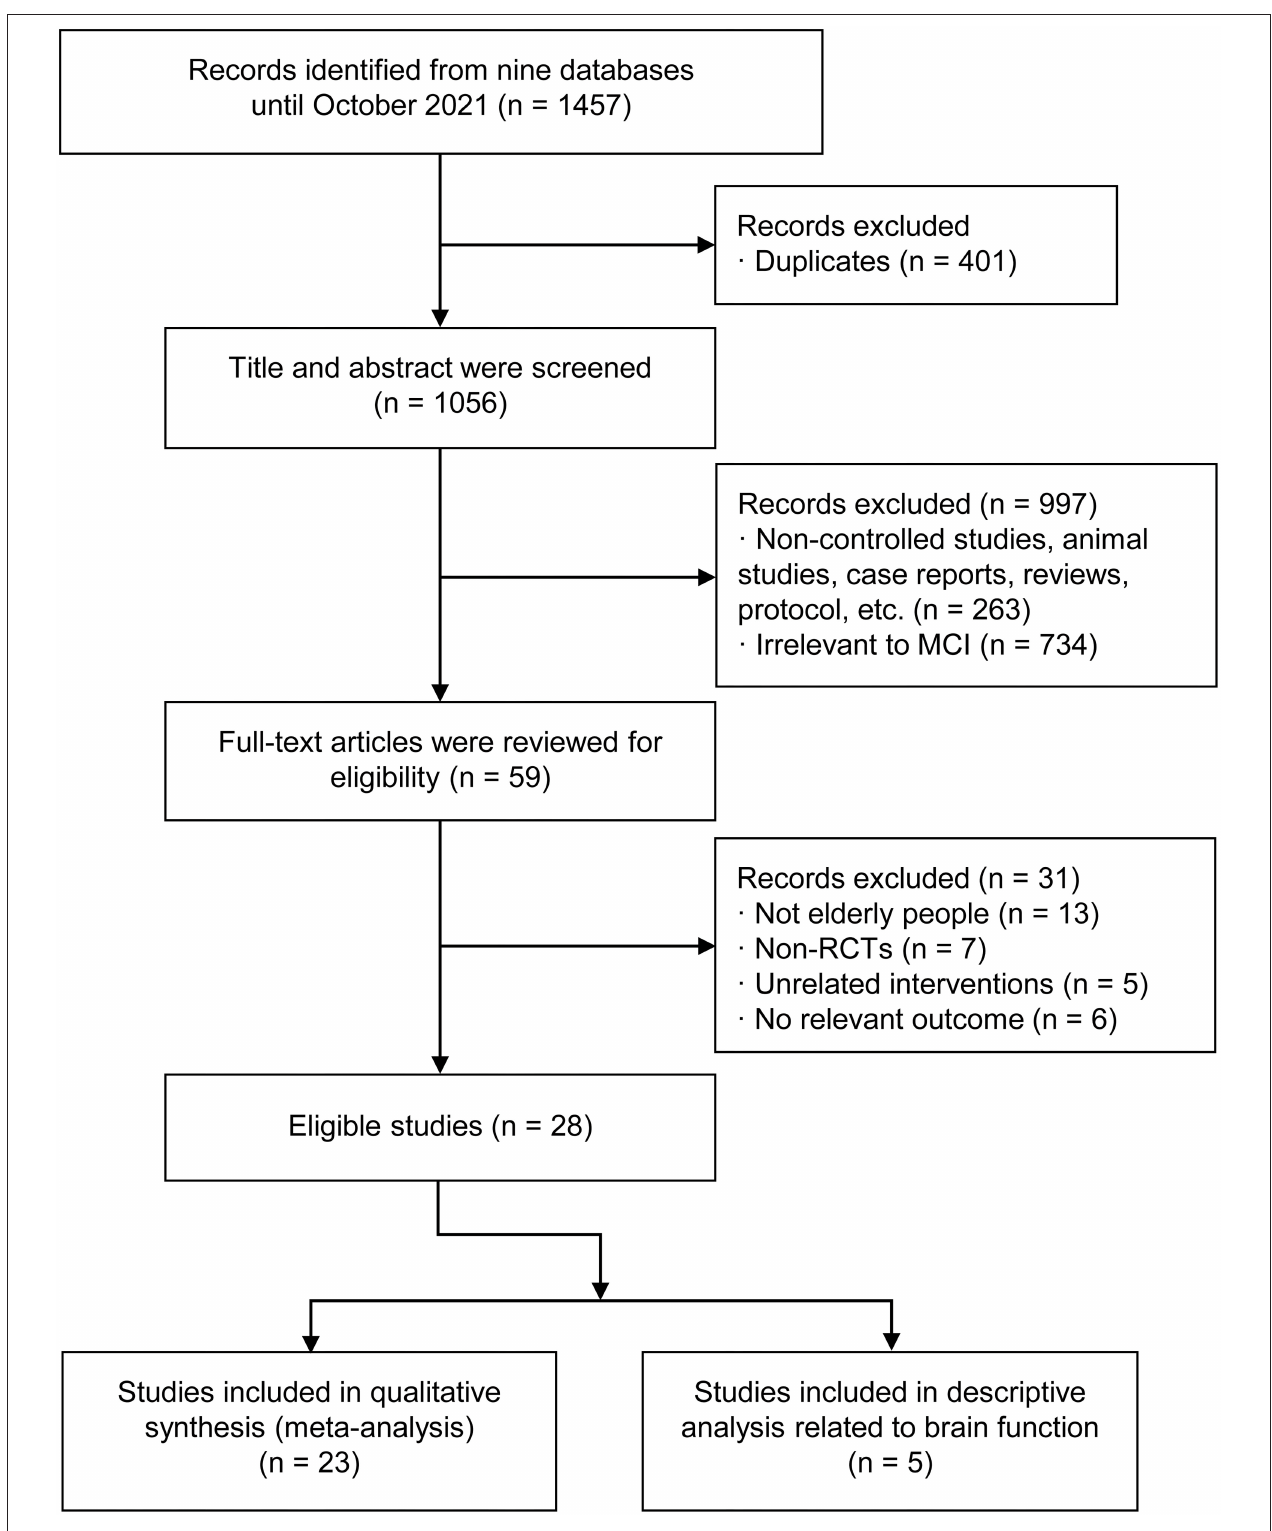
FIGURE 1 | The process of selection of the eligible studies.